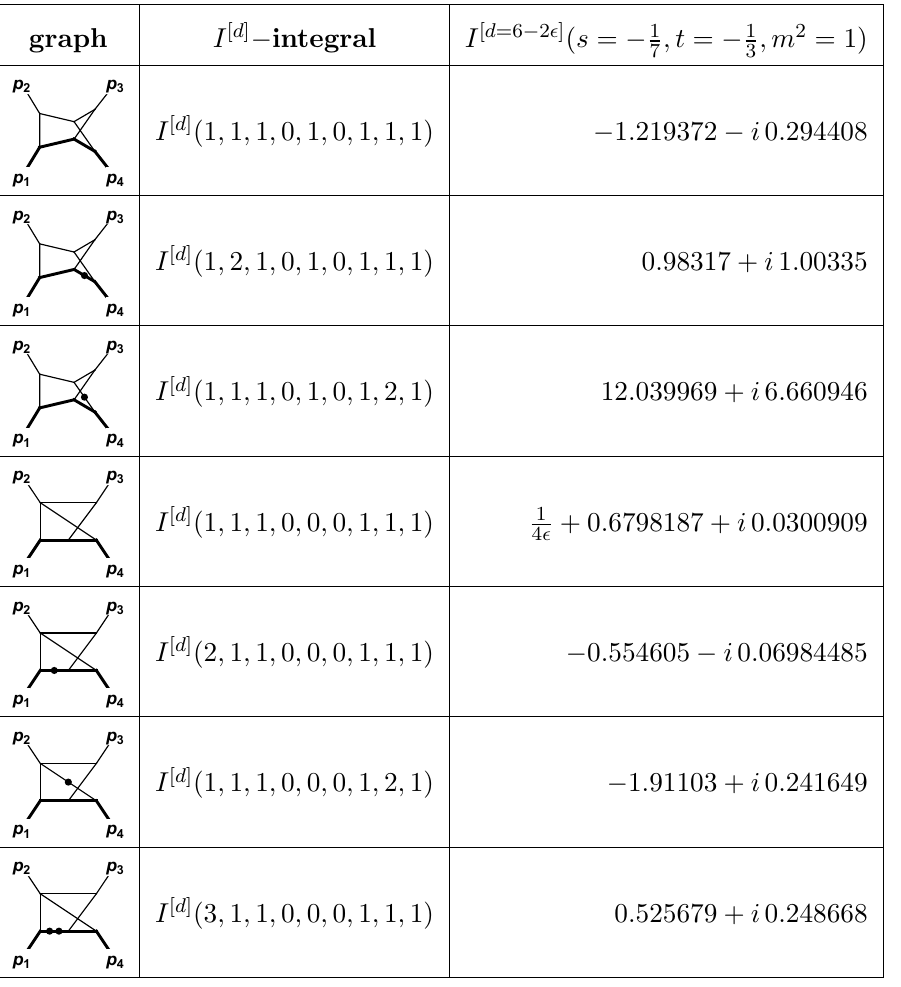
Table 1. Numerical results for our set of quasi-(cid:12)nite non-planar MIs belonging to the 6- and 7-denominators topologies ( m 2 =